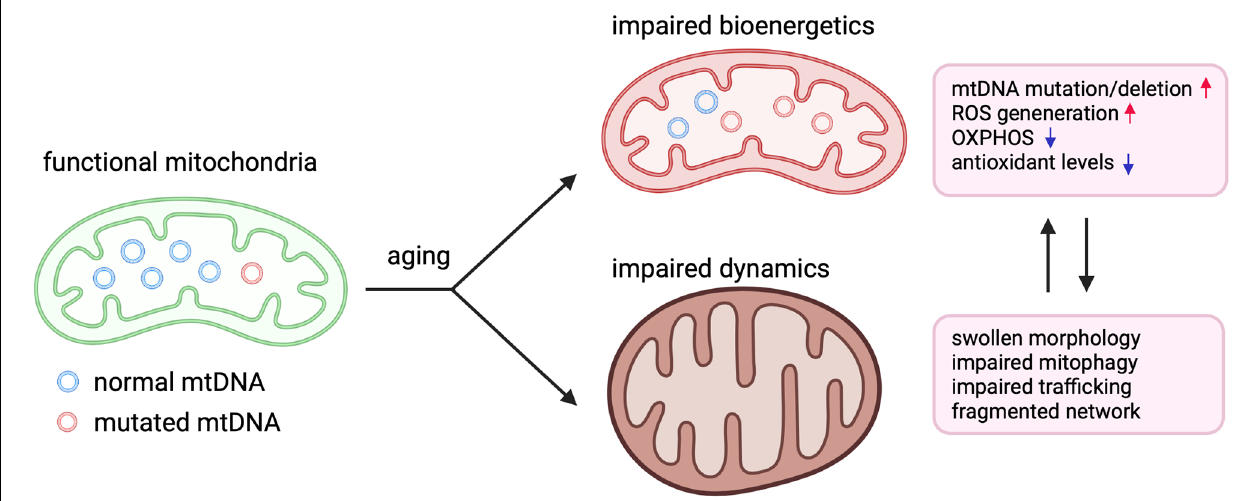
FIGURE 1 | Perturbation of mitochondrial bioenergetics and dynamics in aging. Illustration demonstrating how aging negatively affects mitochondrial bioenergetics and dynamics in aging. In aged humans and animals, higher levels of mutations and deletions in mitochondrial DNA (mtDNA) lead to reduced mitochondrial protein expression and impairments in oxidative phosphorylation (OXPHOS), which exacerbates the generation of reactive oxygen species (ROS). Mitochondria also appear fragmented and swollen while also displaying impaired mitophagy and trafficking to neuronal compartments such dendrites and axons.